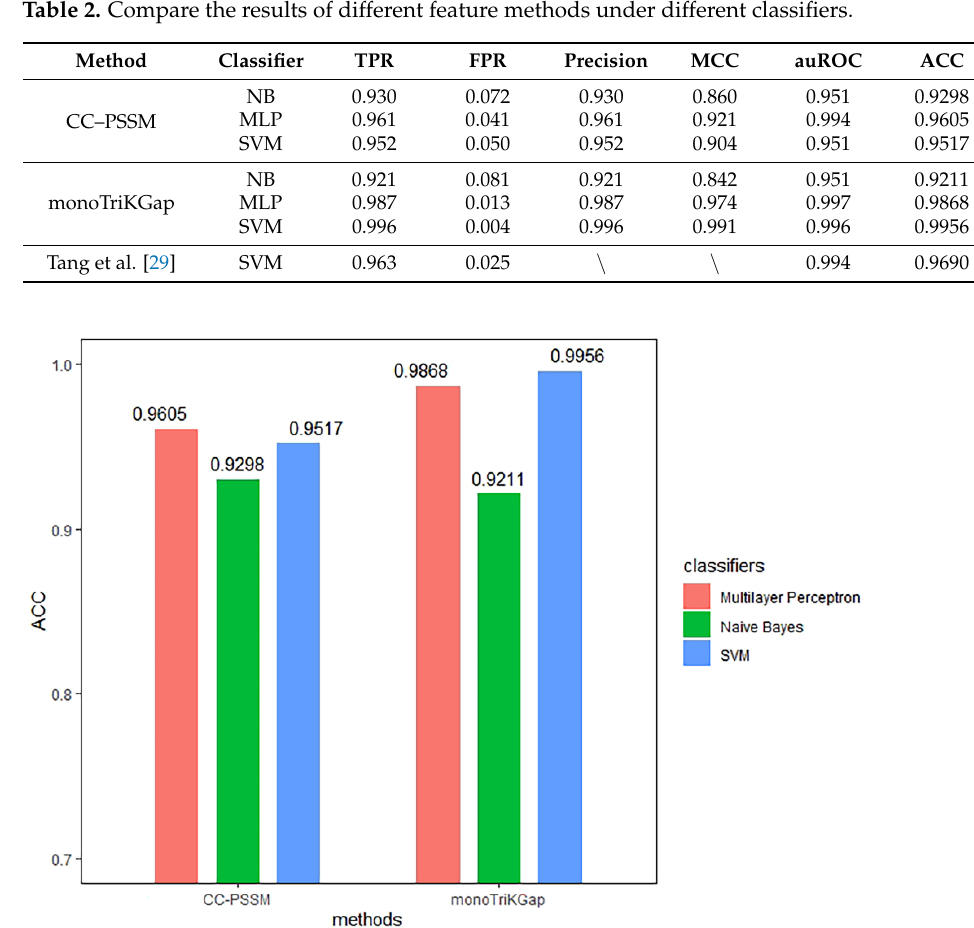
Figure 4. The comparison result of the evaluation index. Comparison of the ACC values between CC–PSSM and monoTriKGap feature representation methods under different classifiers. Table 2. Compare the results of different feature methods under different classifiers.